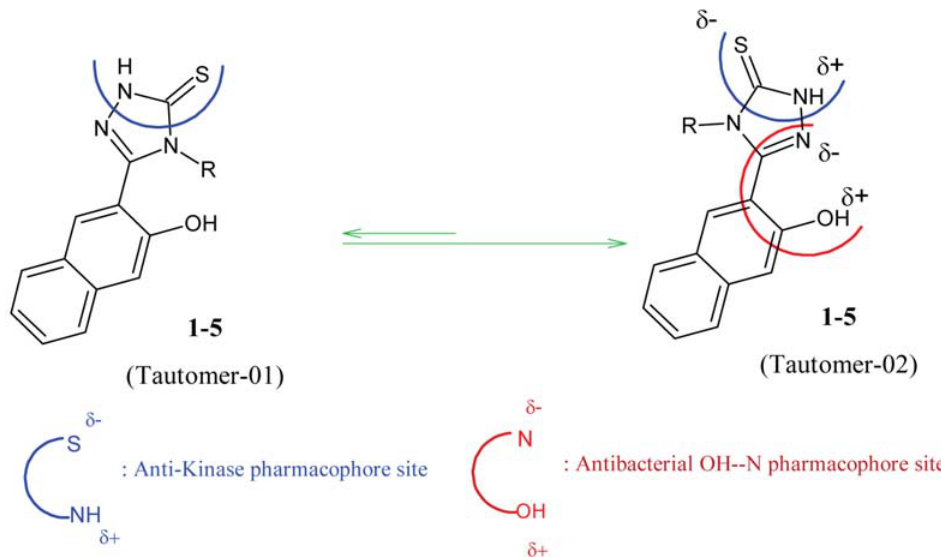
Figure 5. Identification of pharmacophore sites of series